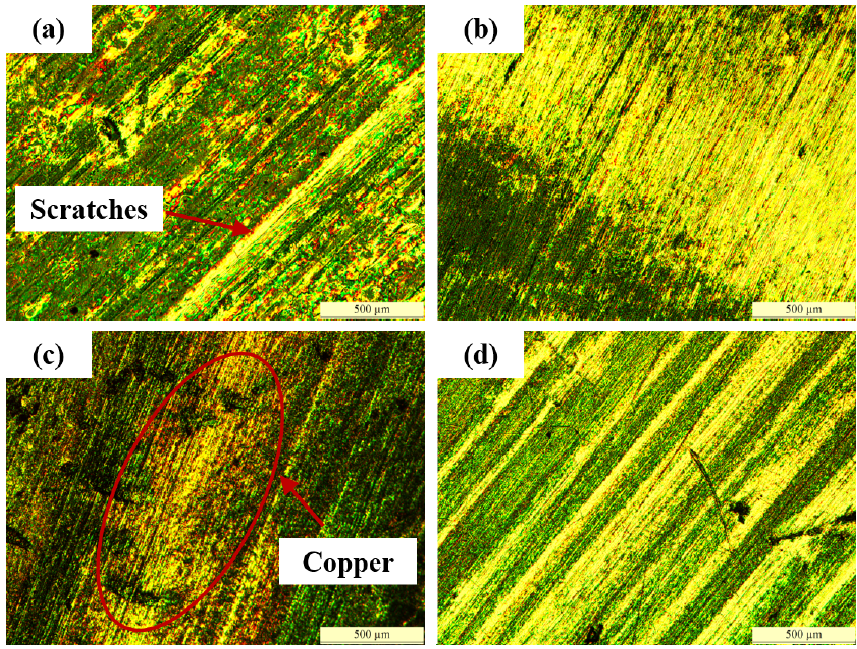
Figure 14. The metallographic diagrams (×50) of the steel plates correspond to the P2 discs of CBFM-A ( a , b ) and CBFM-B ( c , d ).